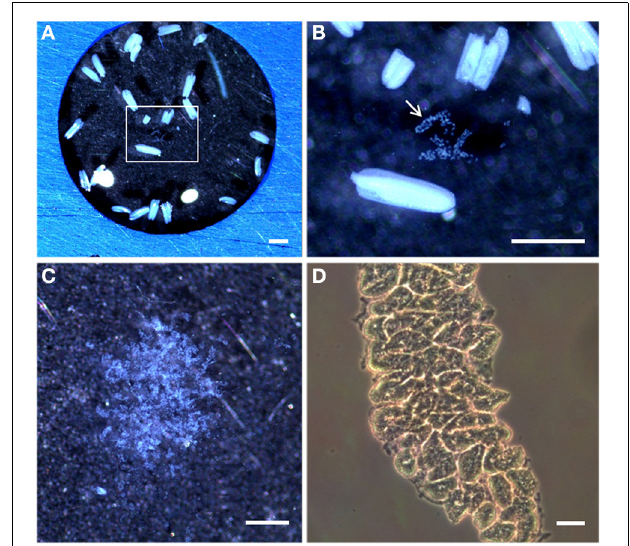
FIGURE 3 | Stereomicroscopy and light microscopy images of rice anthers and isolated meiocytes. (A) Stereomicroscopy observations of rice anthers suspended in a solution PBS and 1% proteinases inhibitors on a multi-well slide. (B) Inset in (A) shows the meiocytes bag (arrowed) from a sectioned rice anther. (C) Rice isolated meiocytes under the stereomicroscope. (D) Light microscopy observations of rice isolated meiocytes in a Neubauer chamber. Bar represents 500 μ m in (A,B) , and 20 μ m in (C,D) .